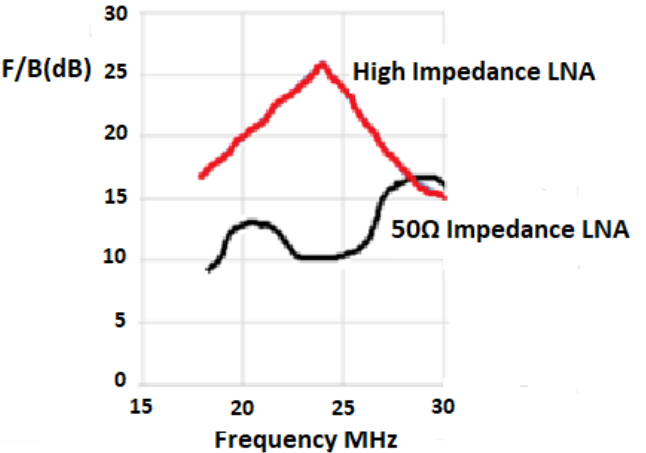
Figure 12. Test results of the phased array between 16 and 30 MHz.